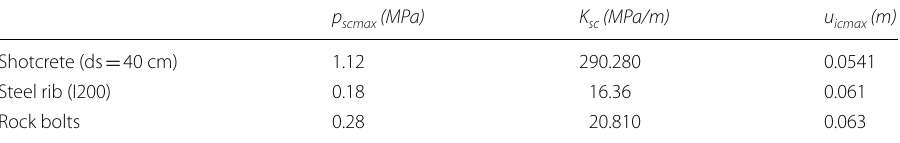
Table 5 Support pressure between entrance portal and km: 210